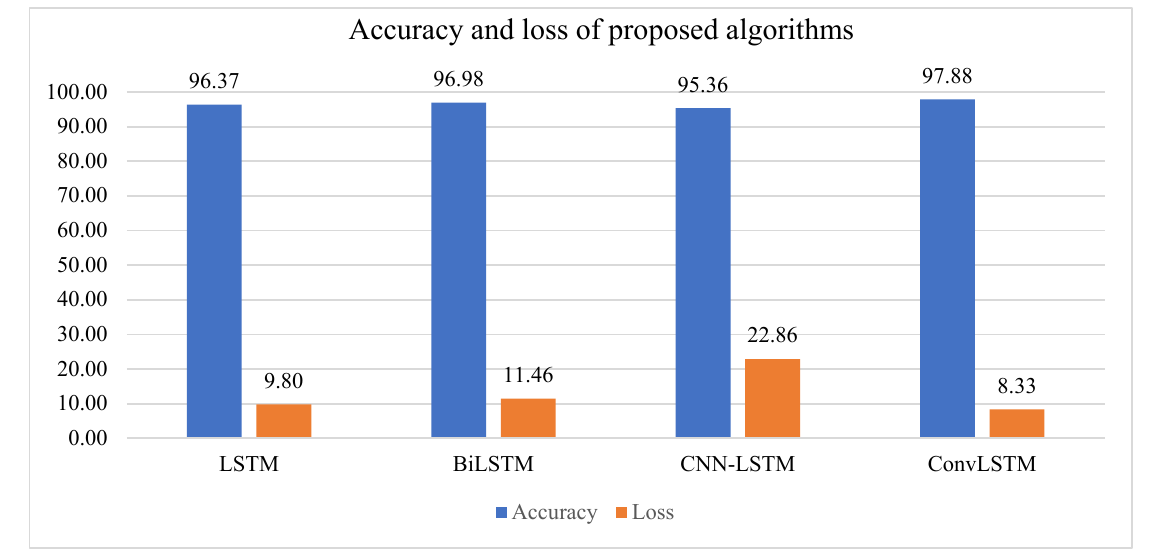
Figure 11. Accuracy and loss of proposed algorithm .